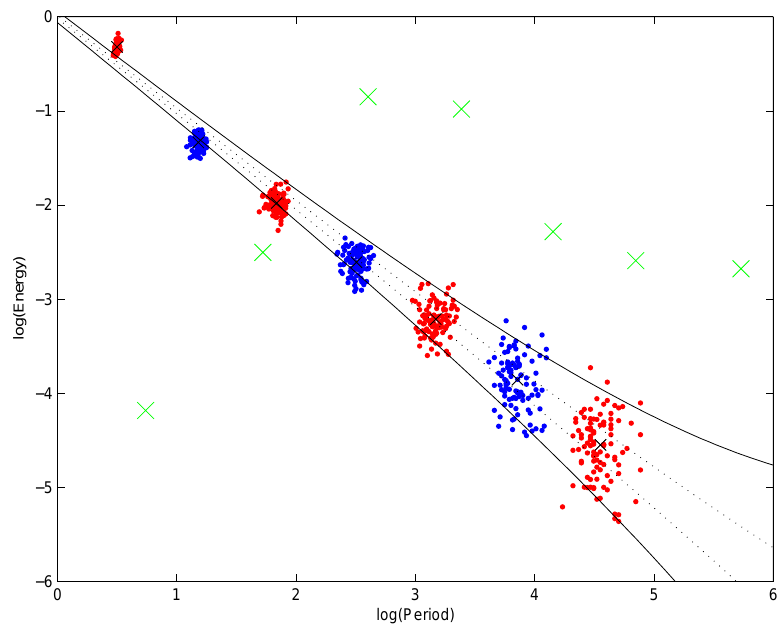
Fig. 3. Log-log diagram of the energy and dominant period of the different intrinsic modes identified by the EMD technique. The separation between observations (green crosses) and Monte-Carlo simulations of white-noise (red and blue dots) displayed in this figure indicate that a range of atmospheric waves can be observed in the Scott Base MF radar data. The black crosses in this figure indicate the center of mass for the individual IMFs produced by the Monte-Carlo simulations. The dotted and full lines indicate the theoretical bounds (75% and 99% limits) within which white-noise should